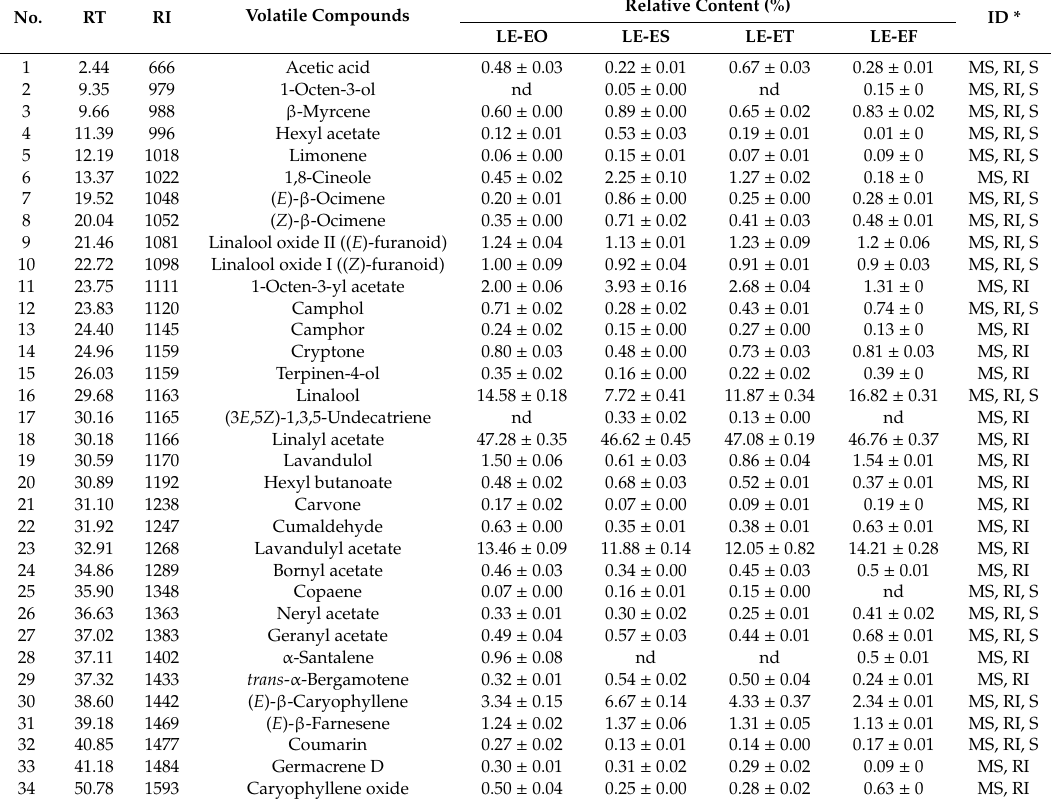
Volatile compositions of lavender extracts with di ff erent extraction times and verification